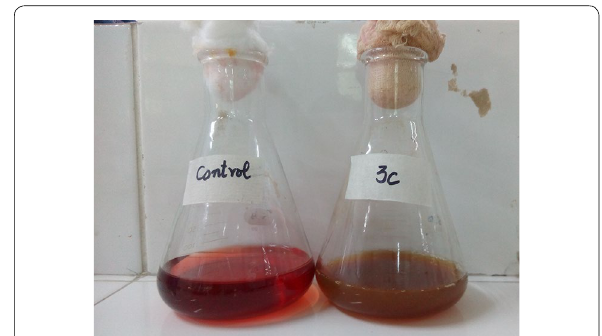
Fig. 1 Change in color of Synazol red 6HBN as compared to control in flask containing culture of bacterial isolate 3c from the dye contaminated